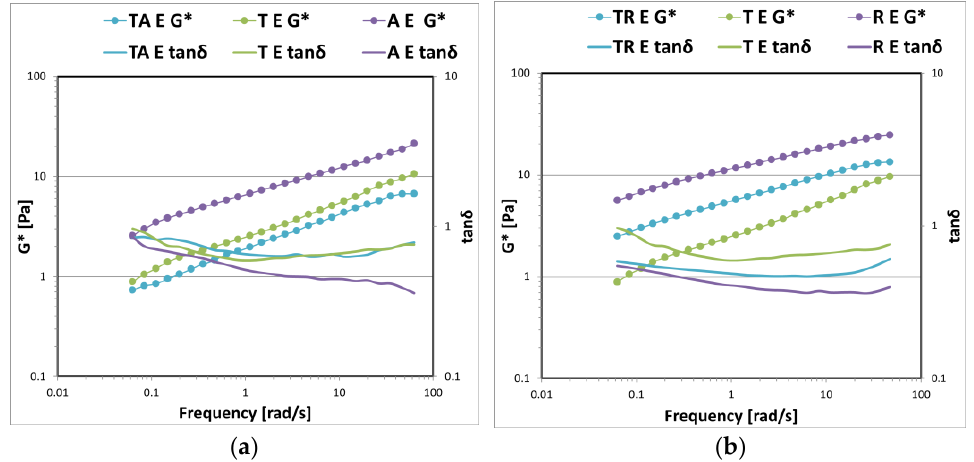
Figure 9. The trend of the complex G* modulus and the damping factor tan δ in the function of the oscillation frequency for the gel – creams prepared with ternary polysaccharides associations: ( a ) sample TA E prepared with T at 0.2% w / w , A at 0.2% w / w and E at 0.3% w / w , sample T E prepared with T at 0.2% w / w and E at 0.5% w / w , sample A E prepared with A at 0.2% w / w and E at 0.5% w / w ; ( b ) sample TR E prepared with T at 0.2% w / w , R at 0.2% w / w and E at 0.3% w / w , sample T E prepared with T at 0.2% w / w and E at 0.5% w / w , sample R E prepared with R at 0.2% w / w and E at 0.5% w / w .